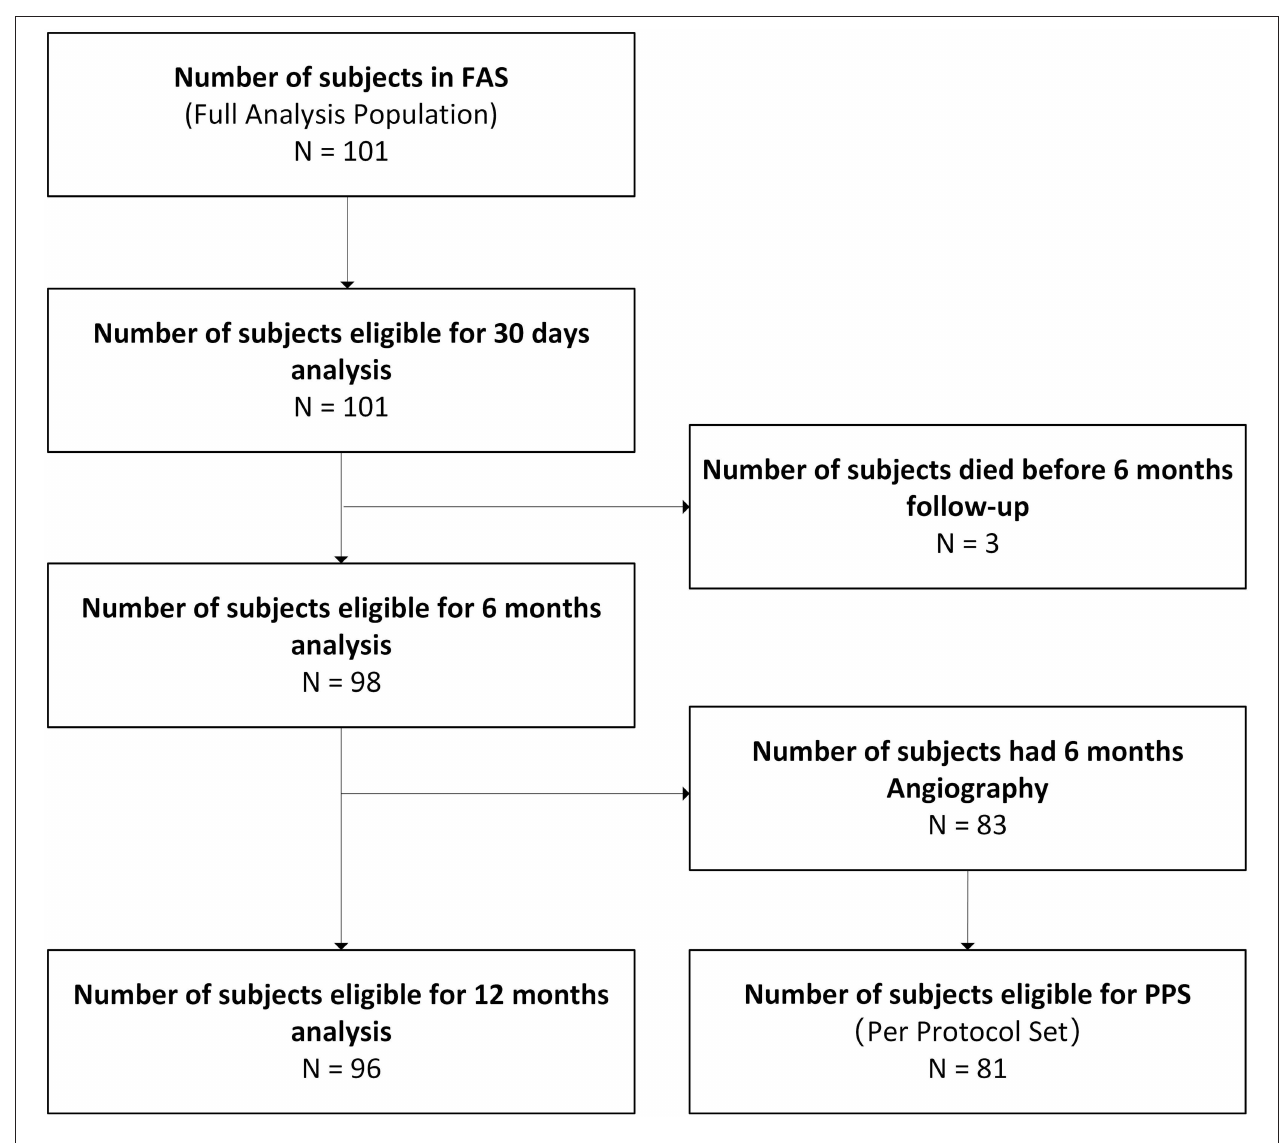
FIGURE 2 | Flowchart of patient